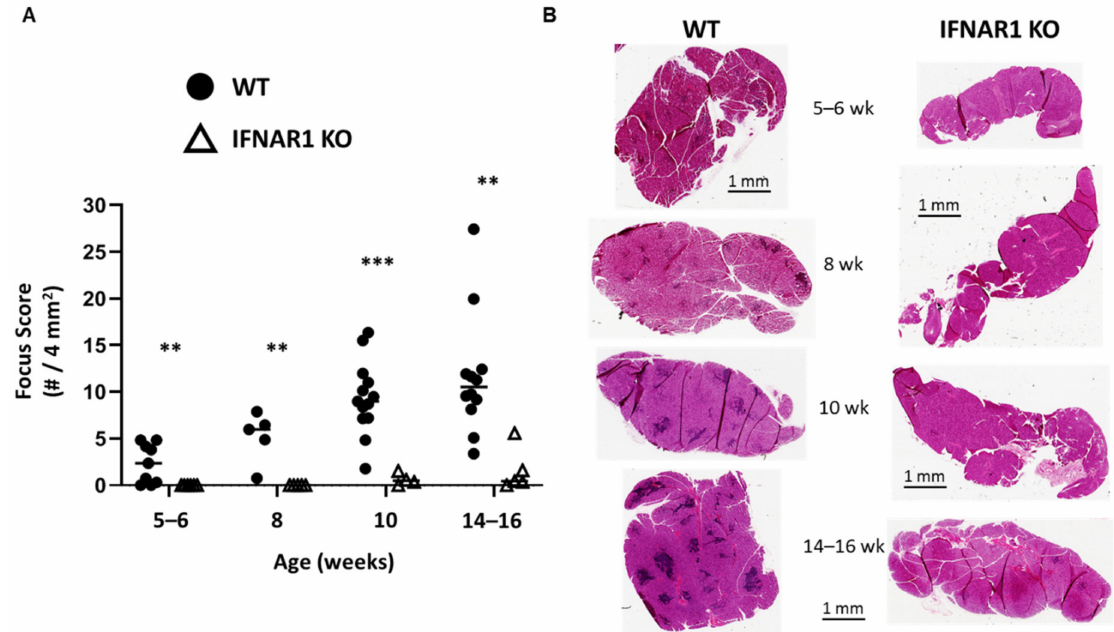
Figure 1. Type I IFN signaling is required for lacrimal gland inflammation. ( A ) Quantitation of lacrimal gland inflammation in WT or IFNAR1 KO NOD mice at different ages: 5-6 weeks ( n = 6 KO, n = 9 WT), 8 weeks ( n = 5 each), 10 weeks ( n = 4 KO, n = 13 WT), 14–16 weeks ( n = 5 KO, n = 12 WT) as indicated (x-axis). A focus is defined as an aggregate of ≥ 50 mononuclear cells, and focus score is equal to # of foci per 4 mm 2 tissue. Symbols represent individual mice in each group (WT, filled circles; IFNAR1 KO, open triangles), lines are medians. ** p < 0.01, *** p < 0.001 by Mann-Whitney test. ( B ) Representative hematoxylin and eosin (H&E)-stained sections of lacrimal glands from WT or IFNAR1 KO NOD mice at indicated ages. Scale bars are 1